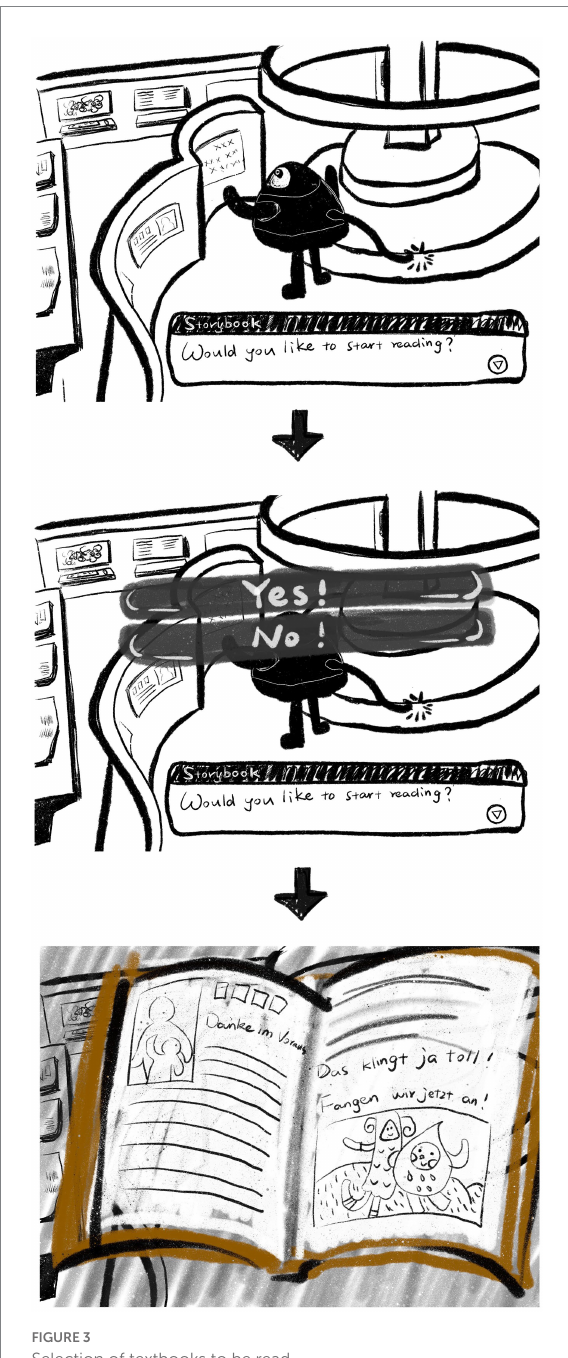
FIGURE 3 Selection of textbooks to be read.